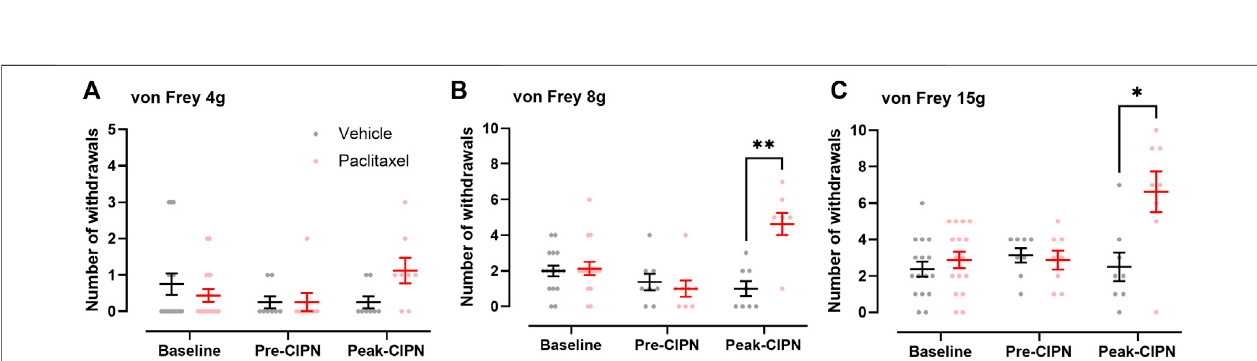
FIGURE 2 | Time course of paclitaxel-induced mechanical hypersensitivity. (A – C) Number of withdrawals (/10) in response to stimulation of the hindpaw with von Frey fi laments of 4 g (A) , 8 g (B) and 15 g (C) at baseline ( n = 16 per group), pre-CIPN (day 7; vehicle n = 13, paclitaxel n = 14) and peak-CIPN (day 25 – 33; n = 8 per group).Individualvaluesandmean±SEMforvehicle (black)andpaclitaxel(red) areshown.Mixed-effects modelwithHolmSidakcorrection(* p < 0.05, ** p < 0.01).Note thatin (A) ,adifferentaxis scalewaschosentobetter visualizepaclitaxel-induced changes. Notethatsomeanimalsfrom thepeak-CIPN groupwerealso tested for mechanical hypersensitivity at day 7 and these data were included in the behavioural analysis at pre-CIPN accounting for the differences in sample sizes.